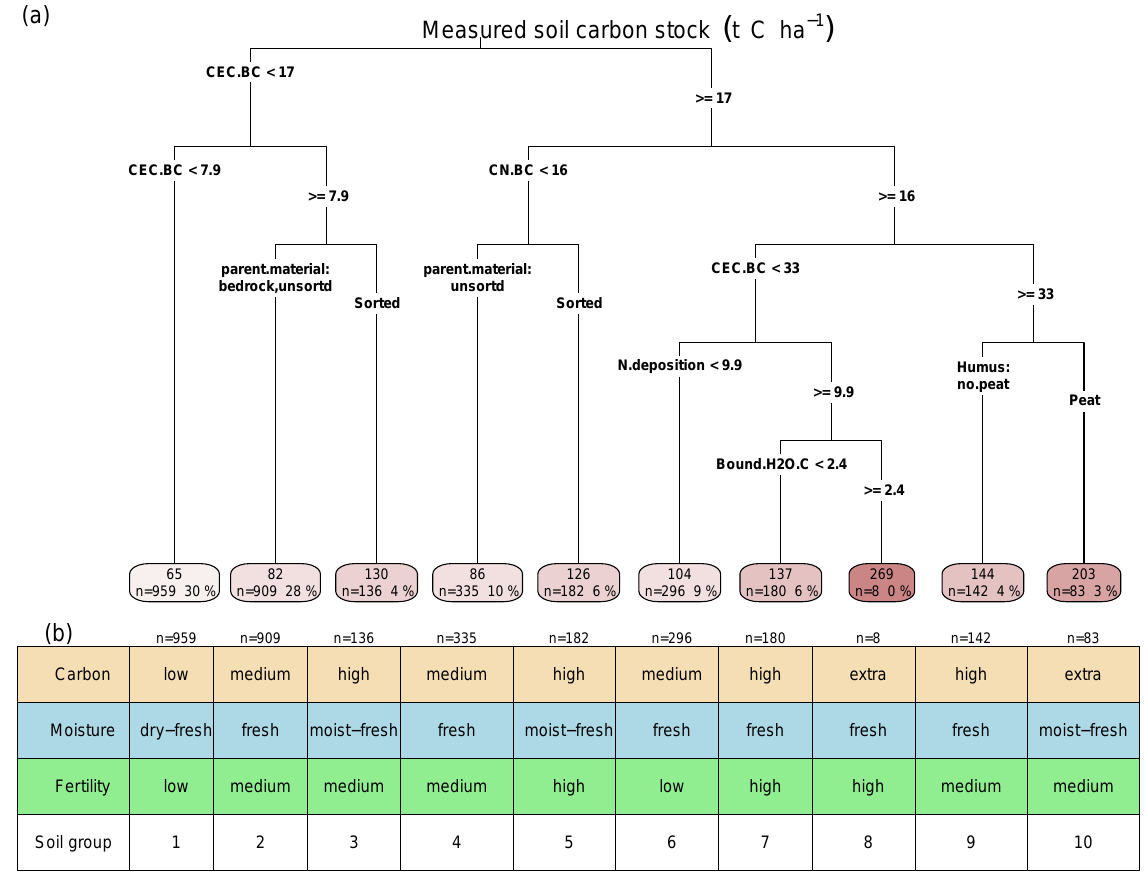
Figure 2. (a) Classification/regression tree for the measured soil carbon stock (tCha − 1 ), soil physicochemical properties, and site envi- ronmental characteristics; the cation exchange capacity of BC horizon (CEC.BC, (mmol c kg − 1 )), the C / N ratio (CN.BC), the nitrogen deposition (N.deposition kgNha − 1 y − 1 ), the highly bound soil water of C horizon (bound.H2O.C, %), and soil class variables as type of sorted or unsorted soil parent material and humus type. Note that variables used to calculate the soil carbon stock (bulk density, carbon content, depth, and stoniness) were excluded from the regression tree analysis. The values in the leaves of the tree show for the distinct en- vironmental conditions mean soil carbon stock (tCha − 1 ), number and percentage of samples. (b) The interpretation of 10